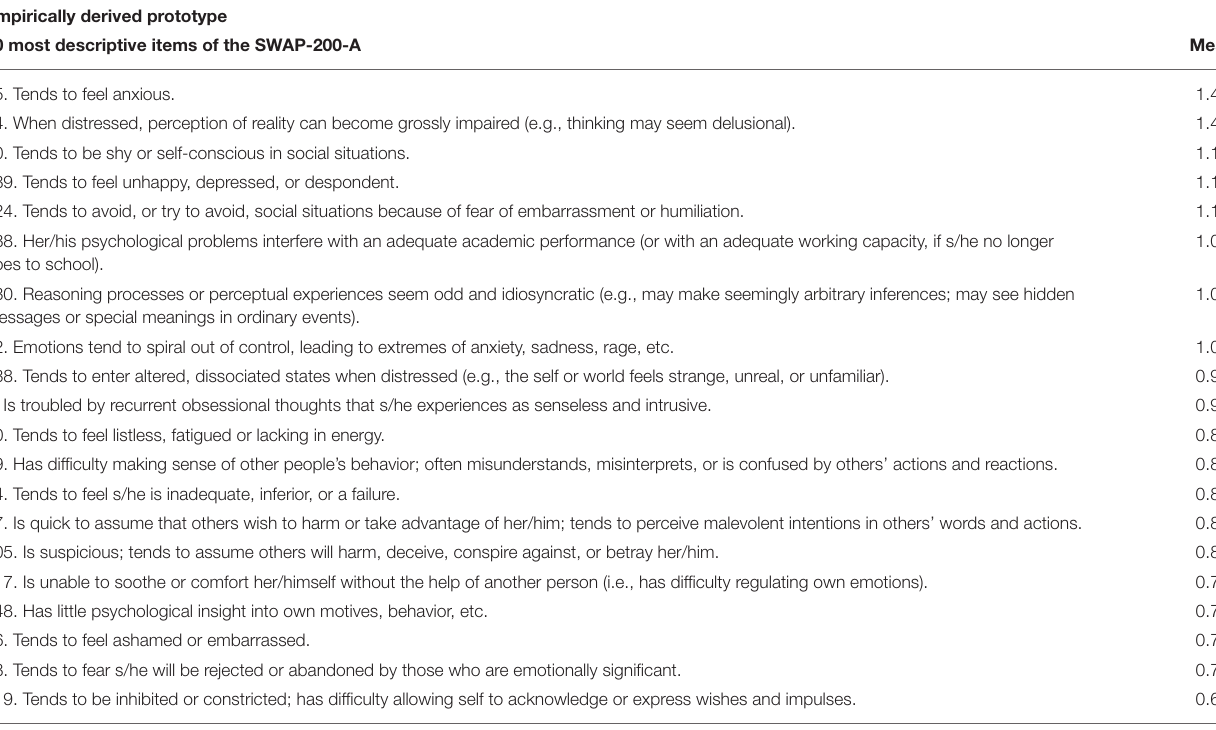
TABLE 2 | SWAP-200-A items most descriptive of the personality and psychological functioning of CHR adolescent patients ( N = 58). Empirically derived